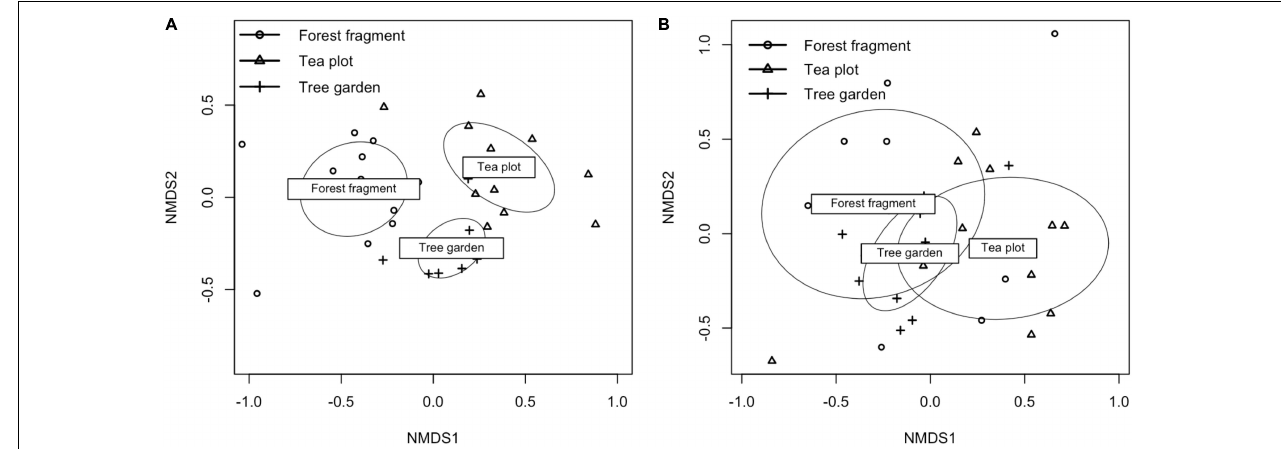
FIGURE 3 | (A) Non-metric-multidimensional scaling of all bird species abundance by land use in two dimensions using Bray-Curtis distance, convergent solution reached after 20 runs. Ellipses capture standard deviation of point for each land use type. (B) Non-metric-multidimensional scaling of endemic bird species abundance by land use in two dimensions using Bray-Curtis distance. TABLE 2 | Variation of multi-species flocks and vegetation across land use types. Variable Forest Tree garden Tea Chi-square or F -test